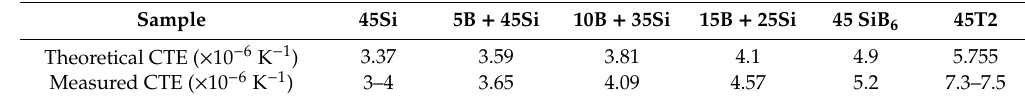
Table 3. Theoretical and measured CTE values of the coating systems.